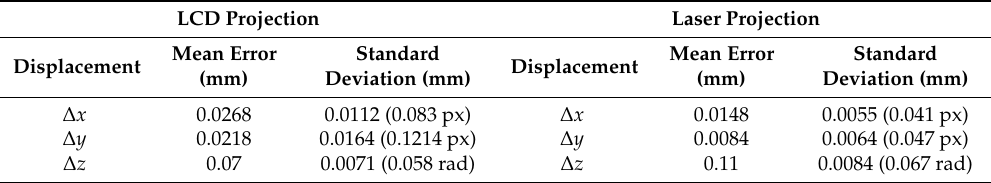
Table 1. Mean and standard deviation obtained for the LCD projection and laser projection system during bending test.